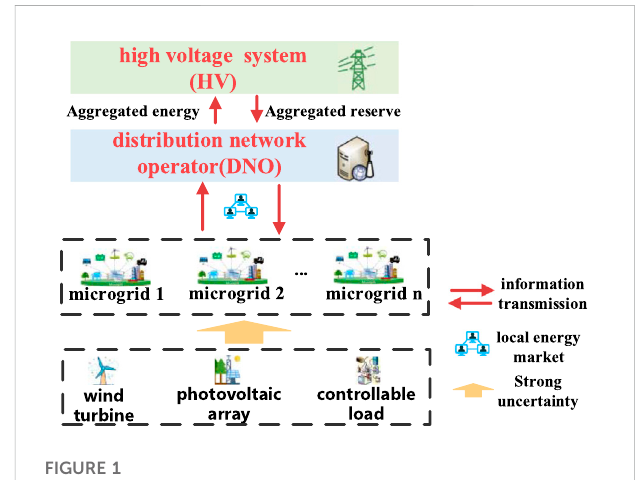
FIGURE 1 Architecture of distribution network system with